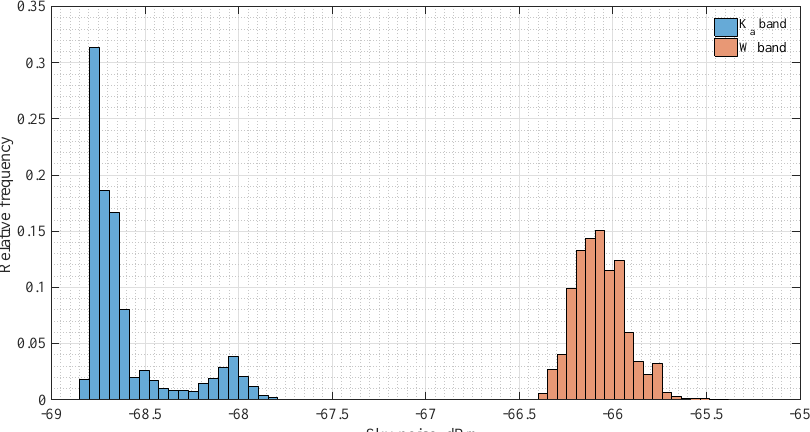
Figure 2. Relative frequency histograms of the sky-noise antenna temperature for the Ka- and W-band radars for all 10 days of the BAECC IOP